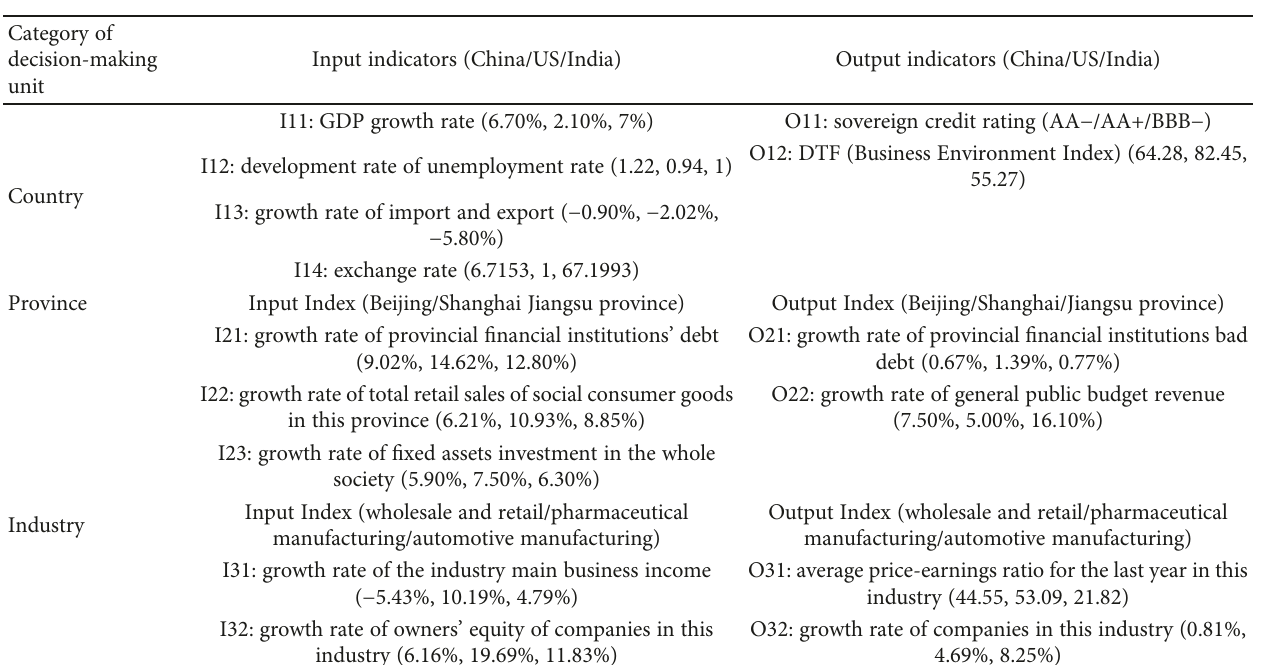
Table 10: Input and output factors impacted the environment system.